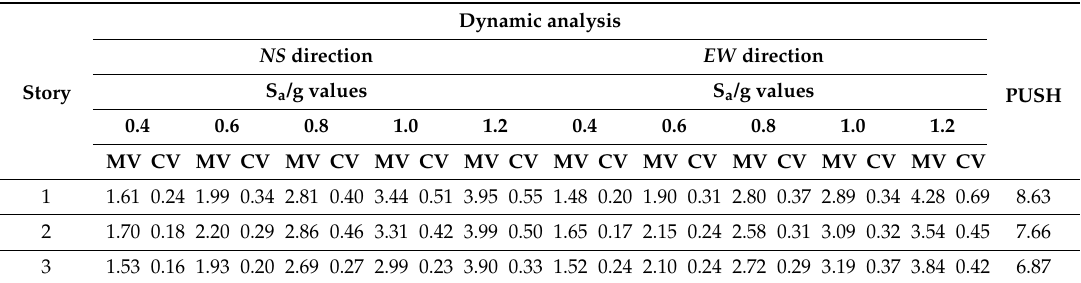
Table 6. Statistics for µ S , 3-level